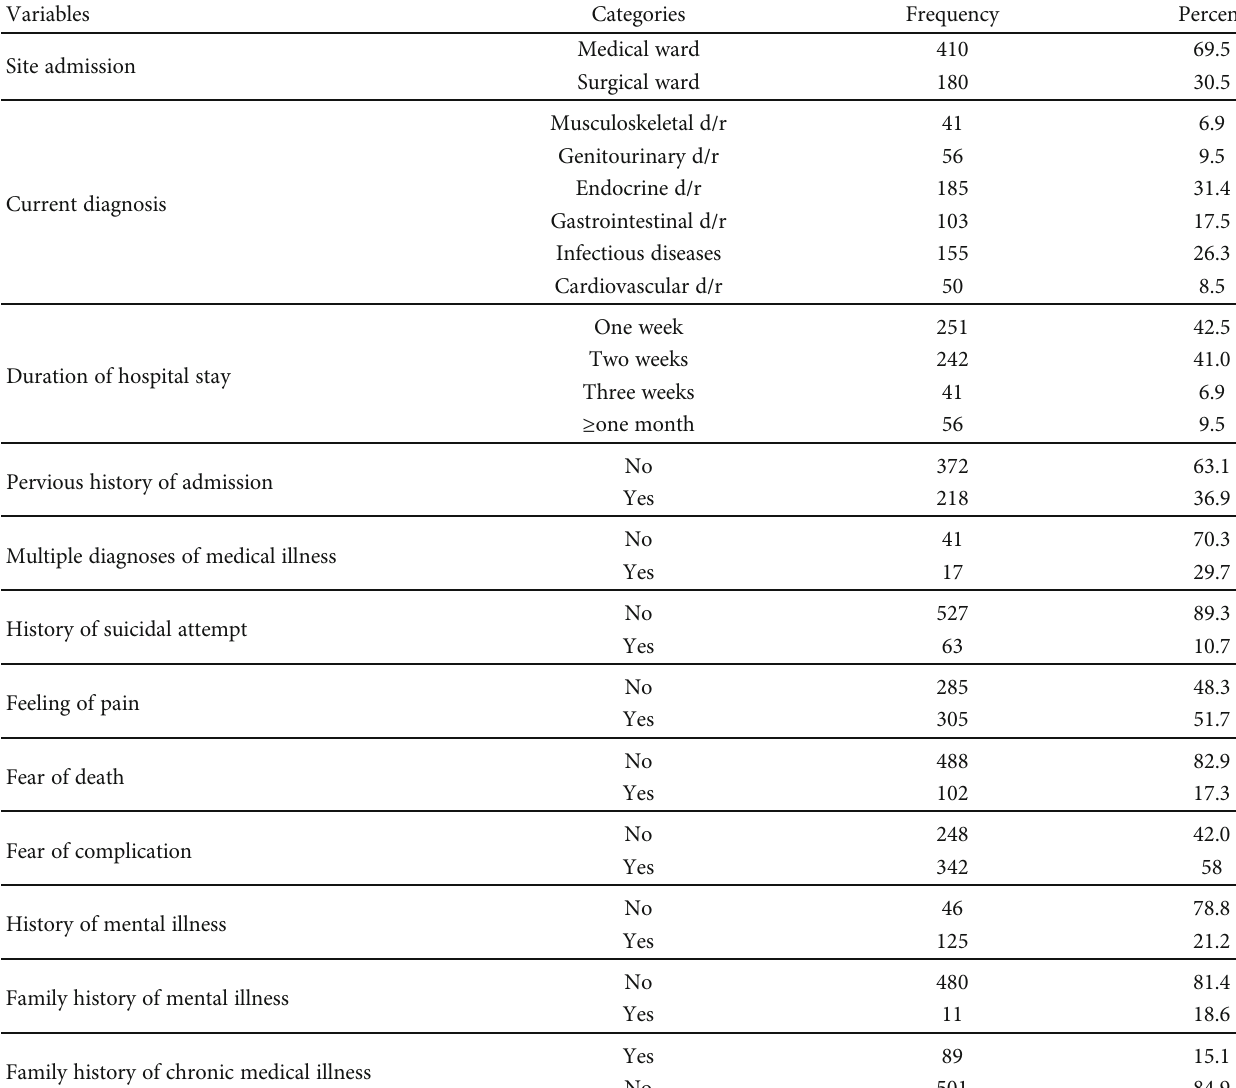
Table 2: Distribution of clinical factors of respondents admitted at medical and surgical wards at SPHMMC, Addis Ababa, Ethiopia, 2019 ( n = 590